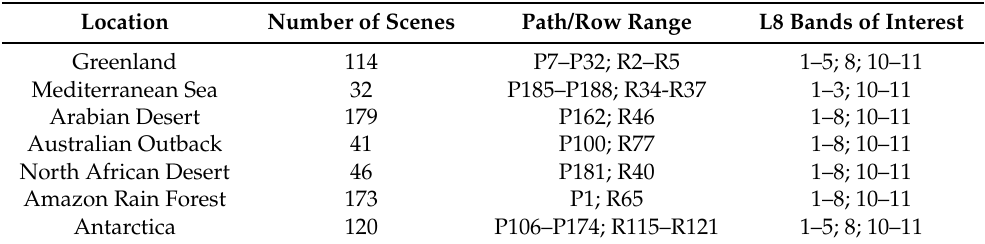
Table 4. Summary of scene locations used for side-slither